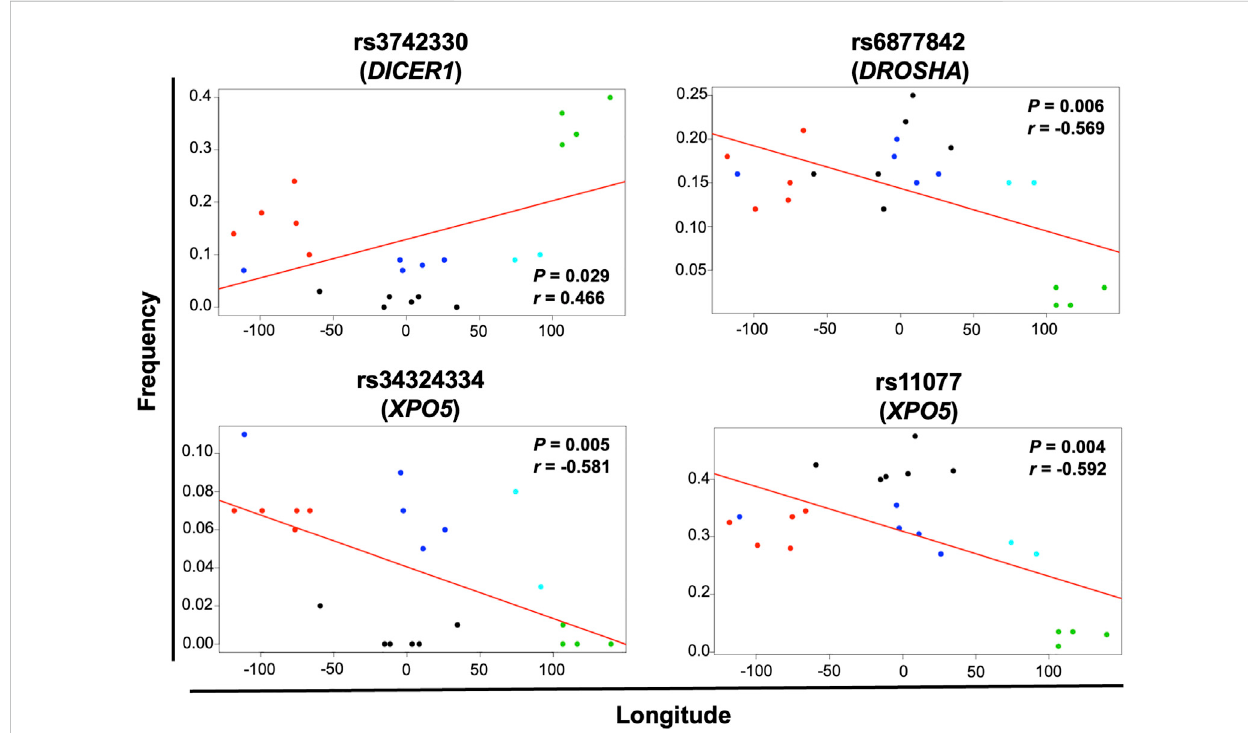
FIGURE 6 Signi fi cant correlation of the minor allele frequency of SNVs with longitude. The correlation of minor allele frequencies reported in sub-continental populations from the 1,000 Genome project and those found in this study for the MEZ population with longitude and latitude was evaluated by the Pearson ’ s correlation test. Gene variants with p < 0.05 for longitude correlation are shown in the fi gure. Black dots = African groups; red dots = Admixed Latino American groups; blue dots = European groups; green dots = East Asian groups; turquoise dots = South Asian